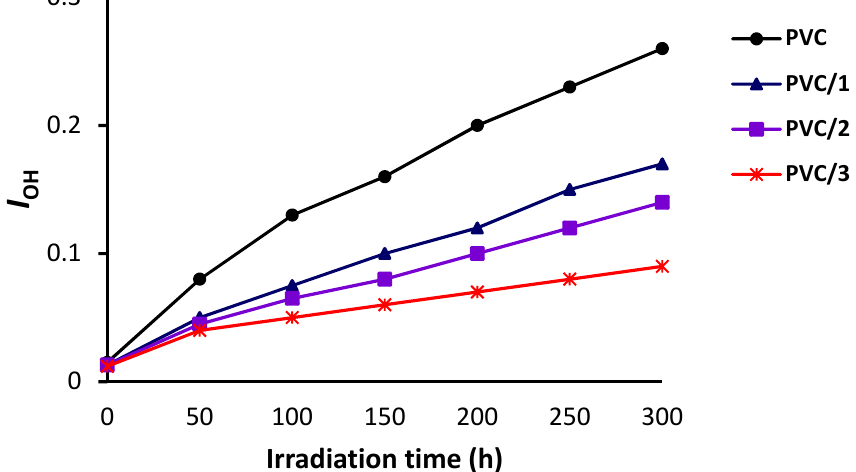
Figure 7. E ff ect of irradiation on the hydroxyl group index ( I OH ) of the PVC Figure 7. Effect of irradiation on the hydroxyl group index ( I OH ) of the PVC films.